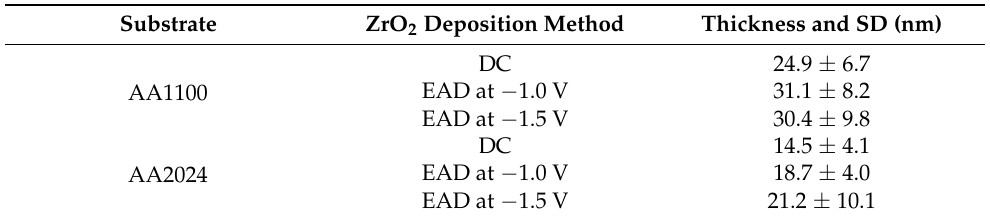
Table 1. Thicknesses of ZrO 2 nanocoatings, obtained by cross-section analysis of FIB-SEM micro- graphs, for samples generated with two different methods. (DC and EAD), and with two different deposition potentials ( − 1.0 V and − 1.5